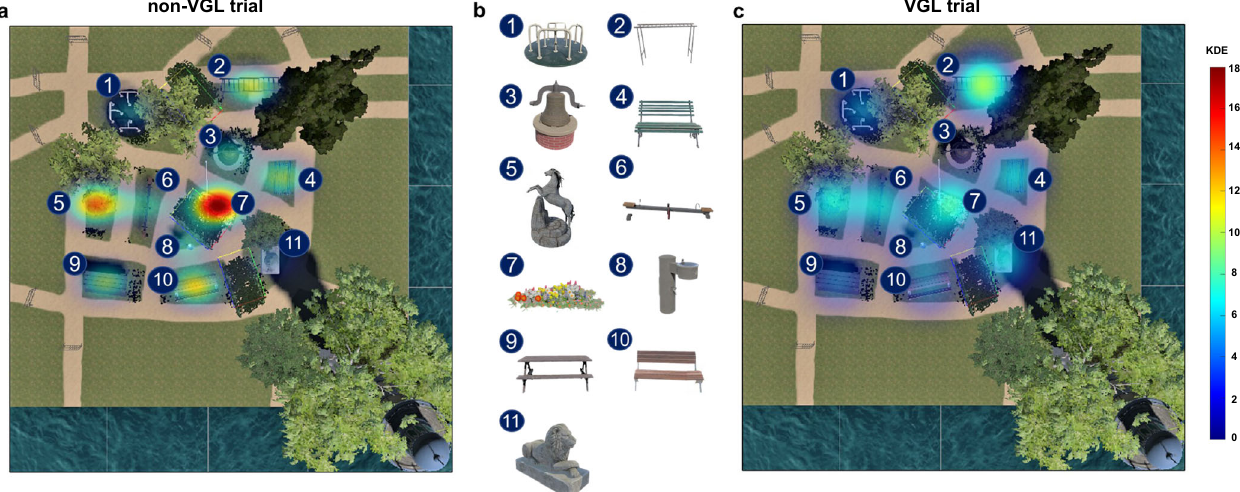
Fig. 3 Heatmap of fi xations on local landmarks during way fi nding and pointing tasks for VGL and non-VGL trials. The background of the heatmaps is the top view of the scenario and the trees surrounding the scenario have been removed for a clear view. a Heatmap of fi xations on local landmarks during way fi nding and pointing tasks in non-VGL trials. b Map of local landmarks in the scenario. Label 1 to Label 11 represent a spinning wheel, monkey bars, a bell sculpture, a green bench, a horse sculpture, a seesaw, a parterre, a water fountain, a picnic table, a brown bench and a lion sculpture, respectively. c Heatmap of fi xations on local landmarks during way fi nding and pointing tasks in VGL trials. The landmark label beside each landmark in the heatmaps is consistent with the respective label shown in b . The colour bar re fl ects kernel density estimation (KED) of fi xations on each landmark.